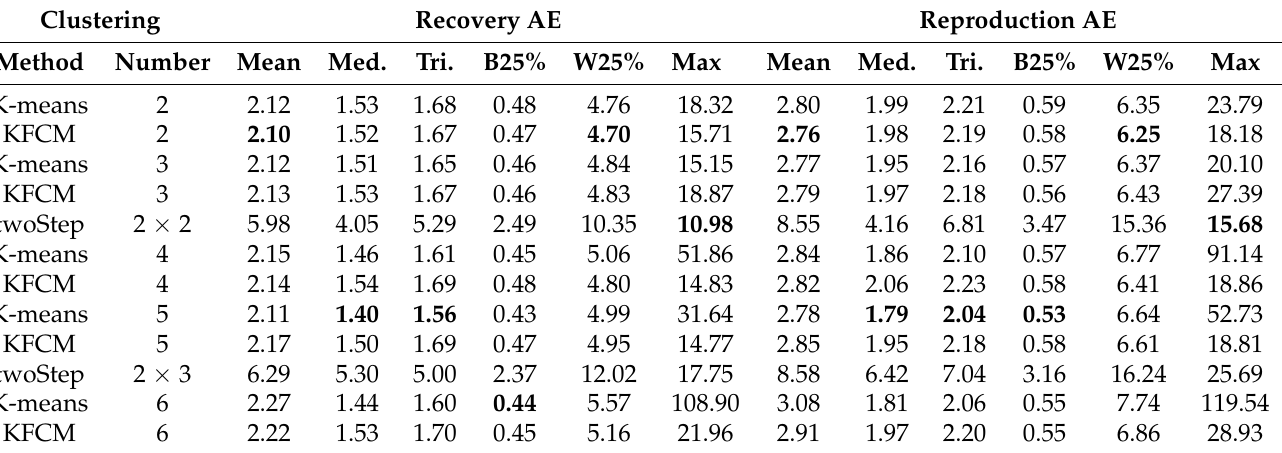
Table 6. Statistical metrics on the combination dataset of Gehler-Shi and Cube+ with different clustering methods and cluster